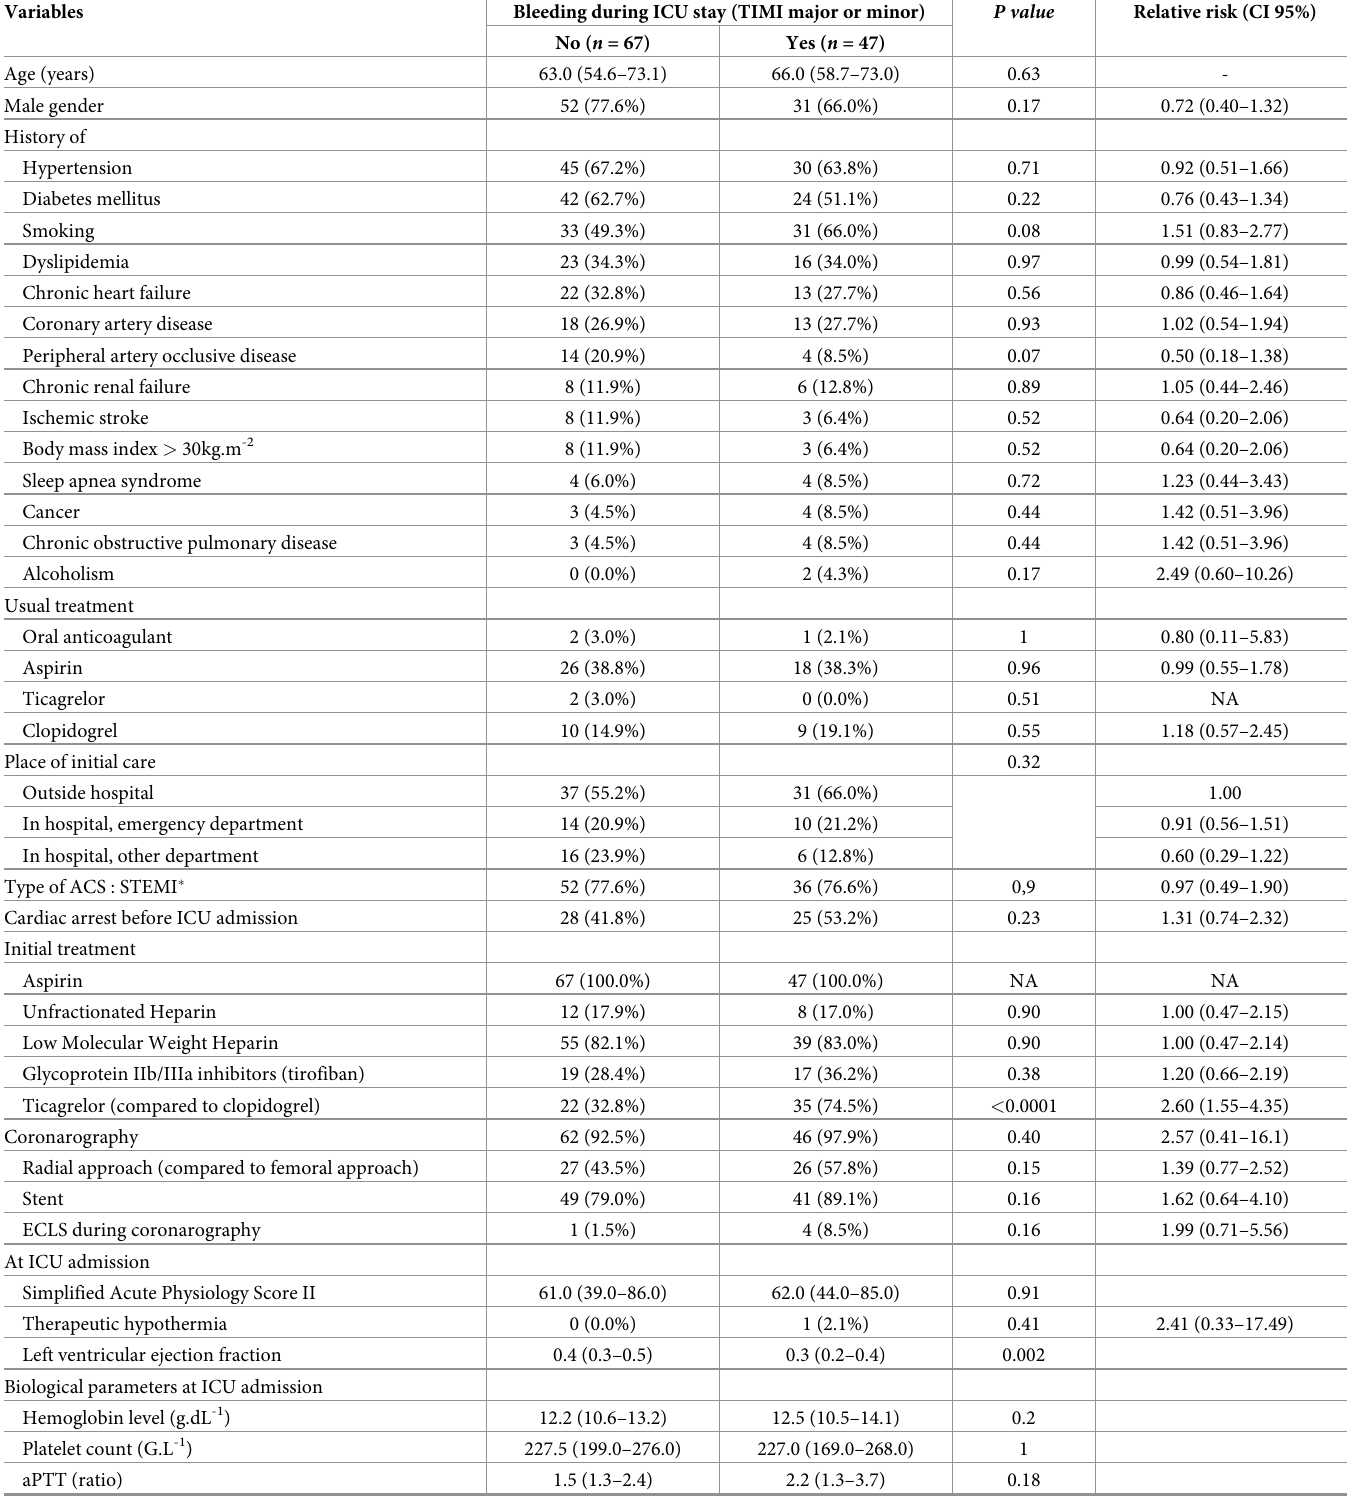
Table 3. Characteristics associated with bleeding before and during ICU